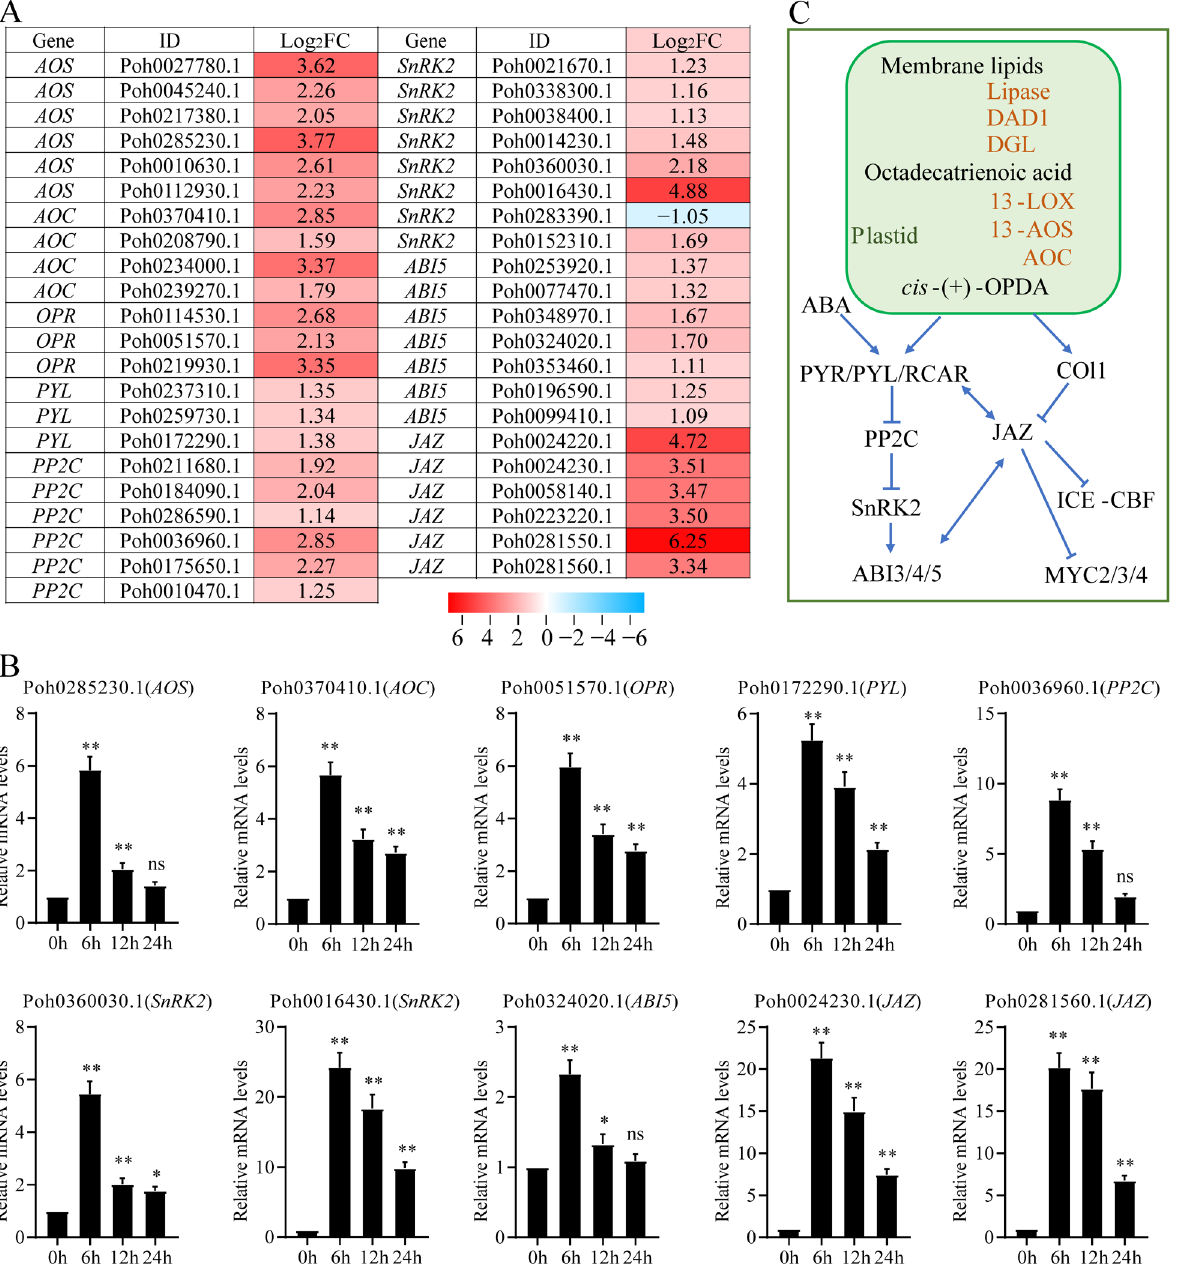
Figure 5. Genes involved in jasmonate and ABA signaling pathways were upregulated under OPDA treatment. ( A ) Heatmap showing that the core components in jasmonate and ABA signaling were markedly upregulated under OPDA treatment in transcriptome sequencing. ( B ) qPCR analysis confirmed that several genes involved in jasmonate and ABA signaling were significantly upregulated under OPDA treatment. AOS , allene oxide synthase; AOC , allene oxide cyclase; OPR , 12-oxophytodienoic acid reductase; ABI5 , abscisic acid insensitive 5; JAZ , jasmonate ZIM-domain protein; PYR / PYL / RCAR , pyrabatin resistance/pyrabatin resistance-like/regulatory components of ABA receptor; PP2C , type 2C protein phosphatase; SnRK2 , sucrose nonfermenting 1-related protein kinase 2. Significant difference (* p < 0.05, ** p < 0.01, ns, no significant). ( C ) A proposed model summarizing the crosstalk between jasmonate and ABA signaling pathways.